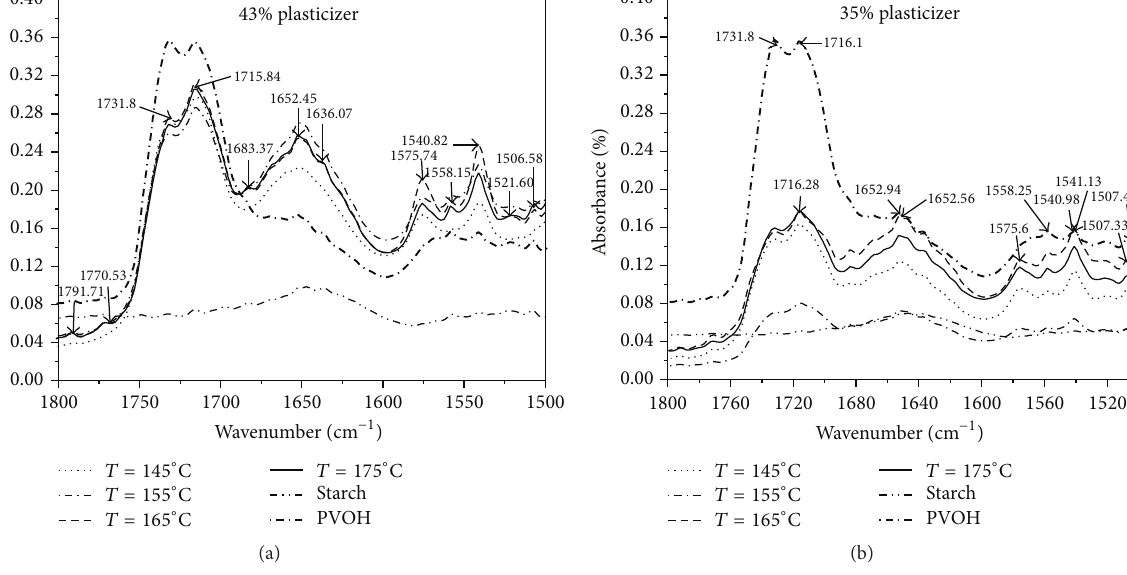
Figure 6: The dependence of ATR absorption in the range of 1800cm −1 to 1520 cm −1 on the plasticizing level ((a) 43%; (b) 35%) and the extrusion temperature (10kg